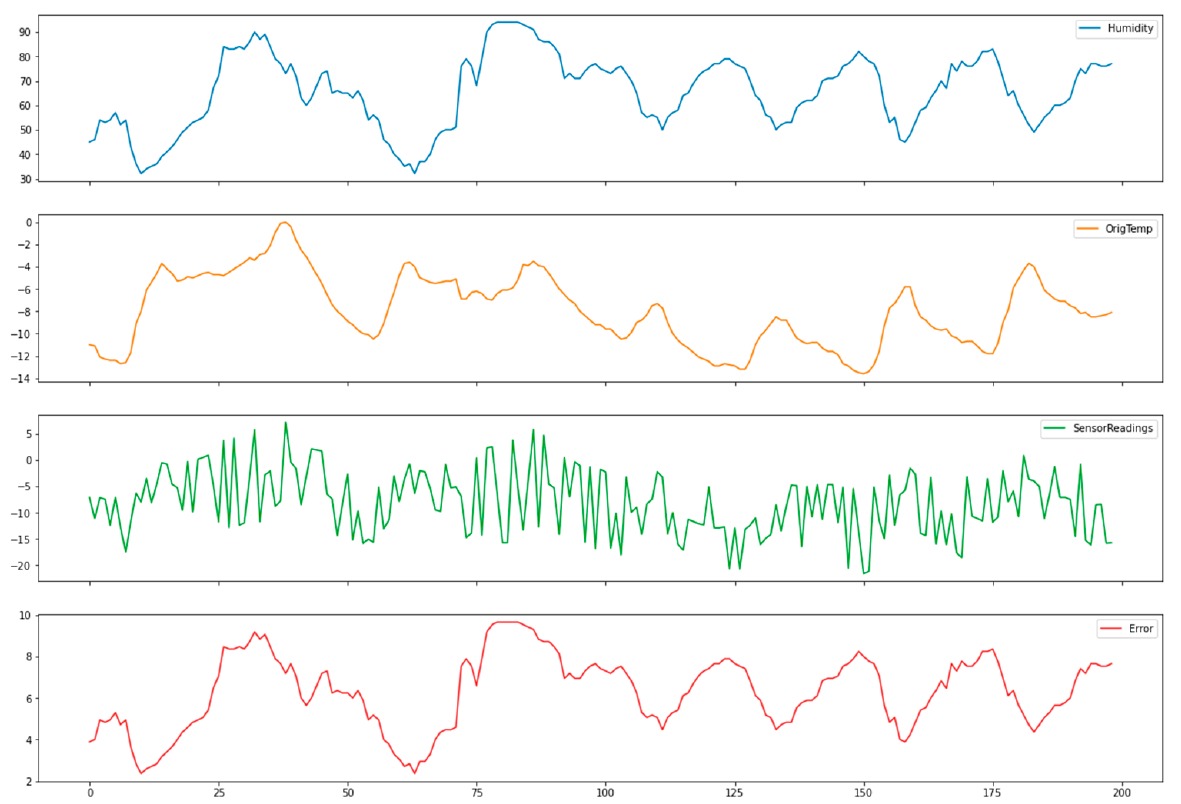
Figure 11. Sample data used for SVM-based alpha-beta filter (200 data instances).